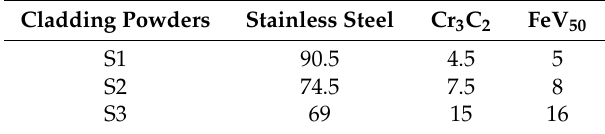
Table 2. Powder proportion of the laser cladded Fe-based coating powders (wt